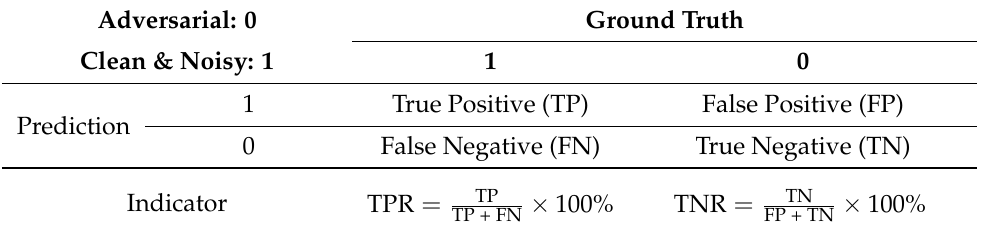
Table 1. Illustration of evaluation metric for detection. Adversarial: 0